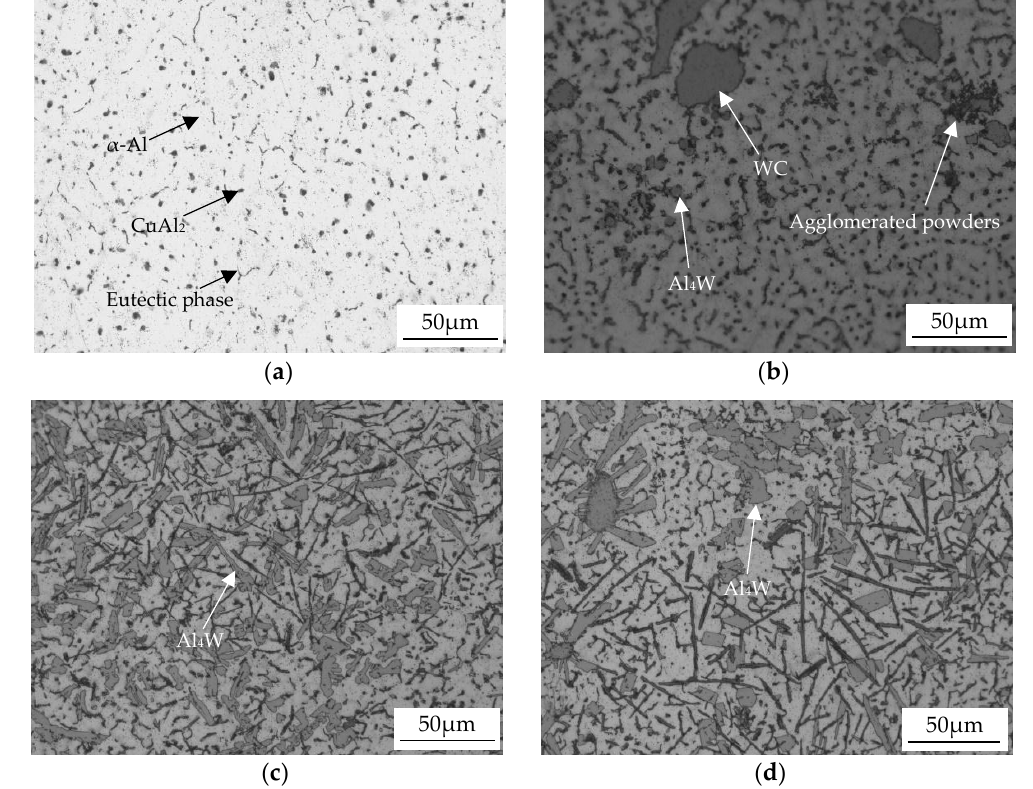
Figure 7. Microstructure of the typical cladding layer: ( a ) 100 wt.% CuZn40; ( b ) 70 wt.% CuZn40 +